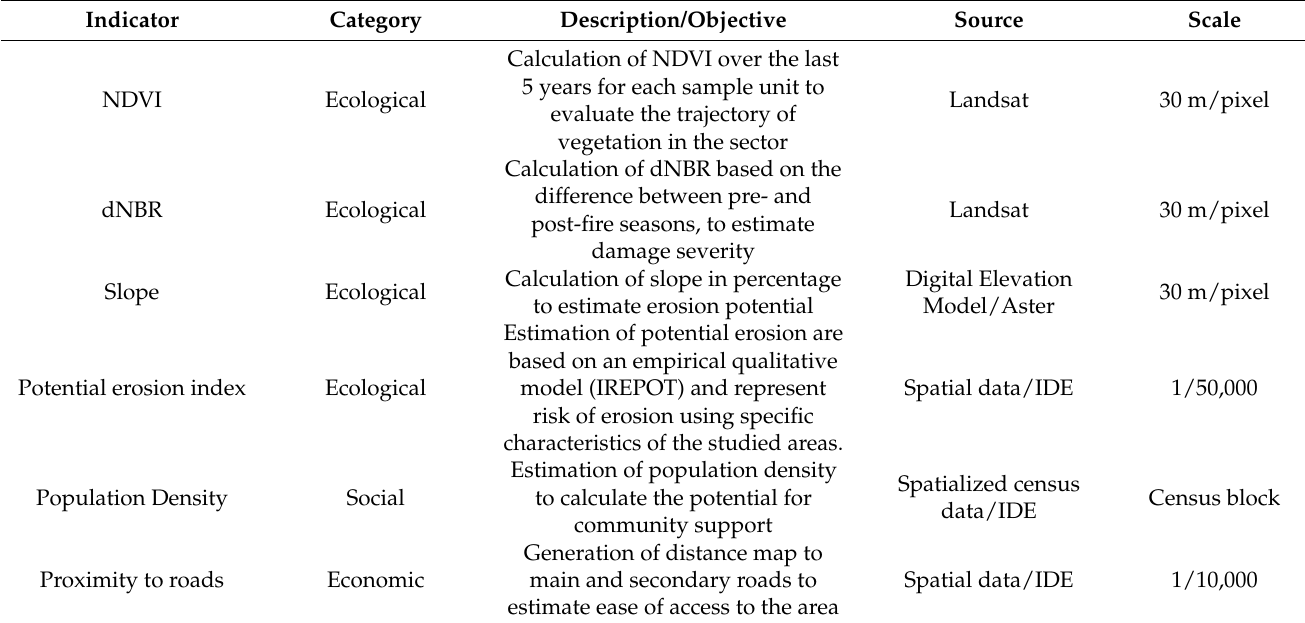
Table 1. List of selected main indicators including classification and basic